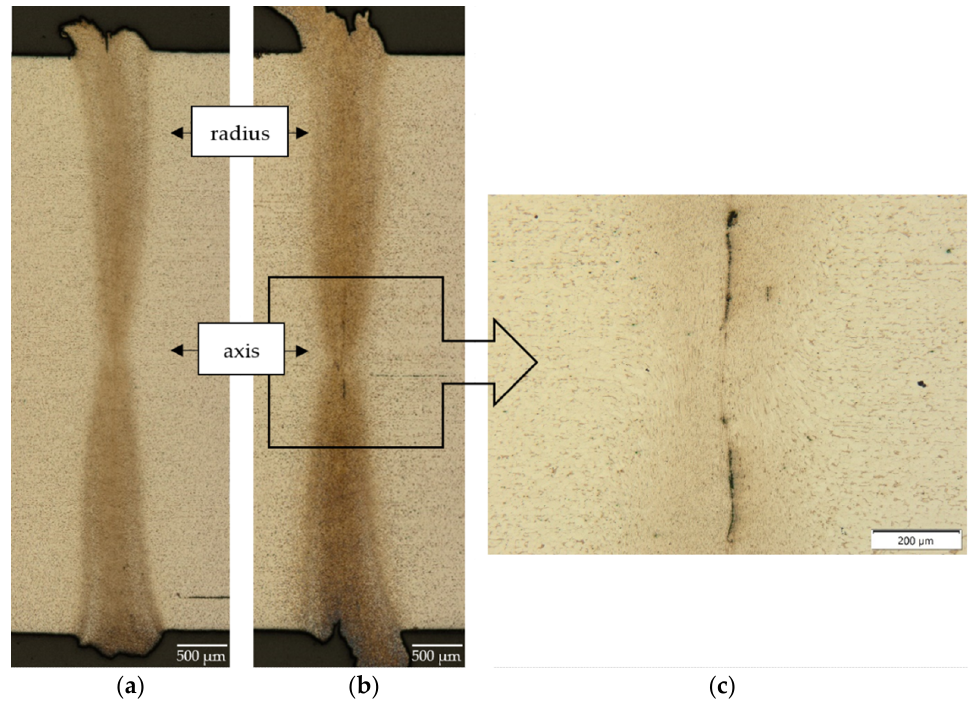
Figure 3. Macrostructures of high-speed friction-welded joints ( a ) with p f = 191 MPa, ( b ) with p f = 127.3 MPa; ( c ) Microstructure of the observed discontinuity.